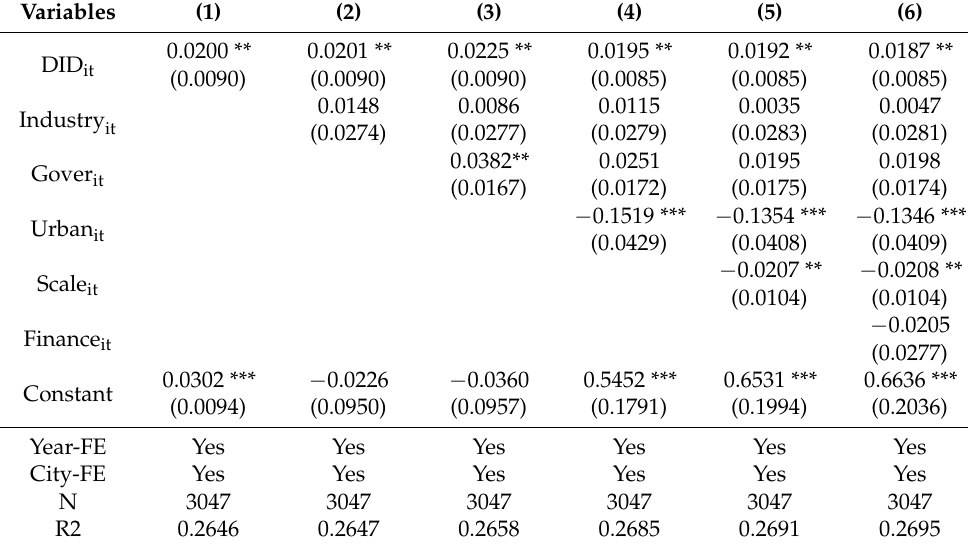
Table 2. Benchmark Regression